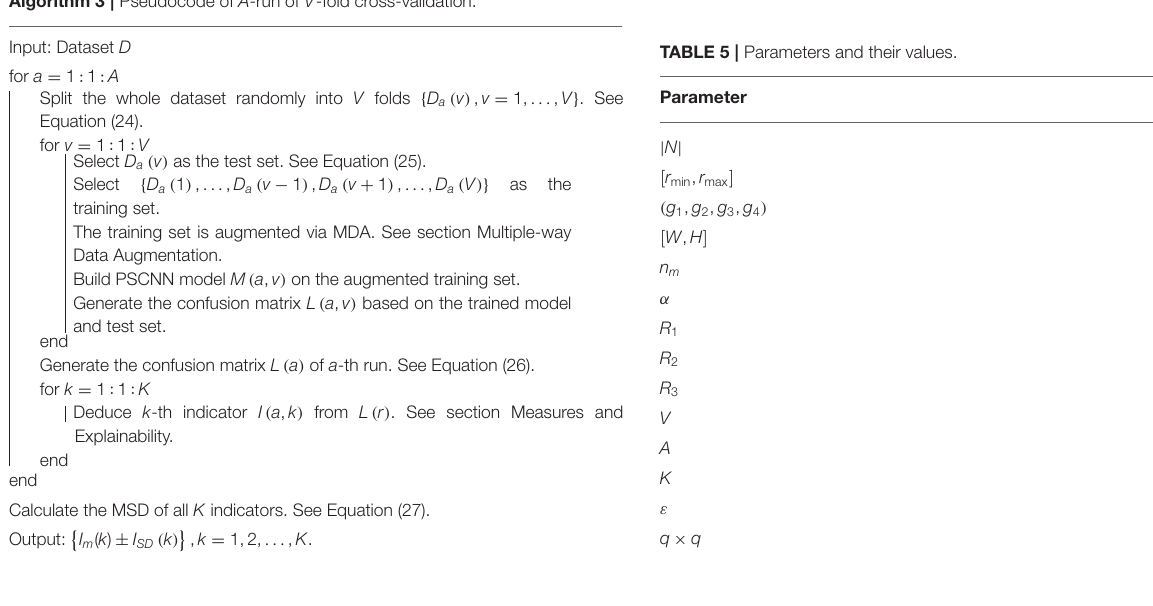
Algorithm 3 | Pseudocode of A -run of V -fold cross-validation.